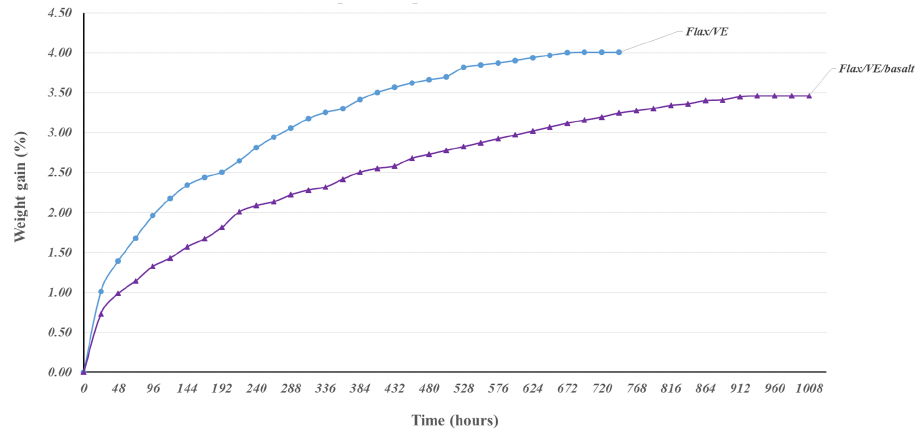
Figure 8. Water absorption comparison of flax/VE and flax/VE/basalt hybrid composites.